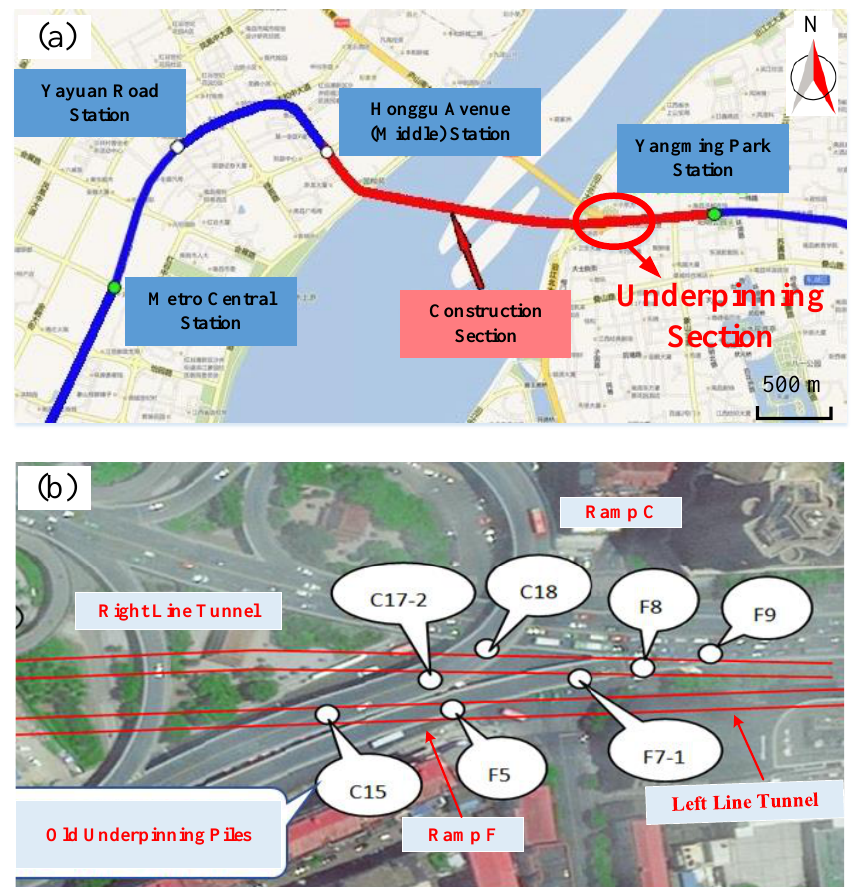
Figure 1. Engineering background of the shield tunnel of Nanchang Metro Line 4 passing through the bridge pile foundation of Bayi bridge: ( a ) location of the underpinning section; and ( b ) layout of the underpinning piles. Table 1. Classification of surrounding rock in shield tunnel